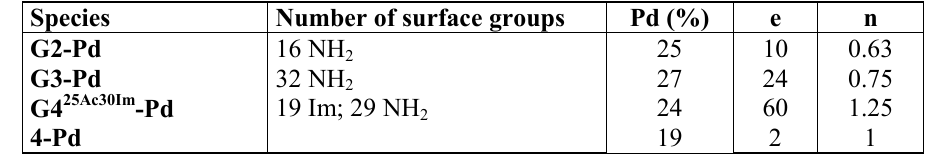
Table 1. The percentage of Pd(0) in adducts, number of Pd(0) equivalents per molecule (e) and number of Pd(0) atoms per one surface functional group (n). Species